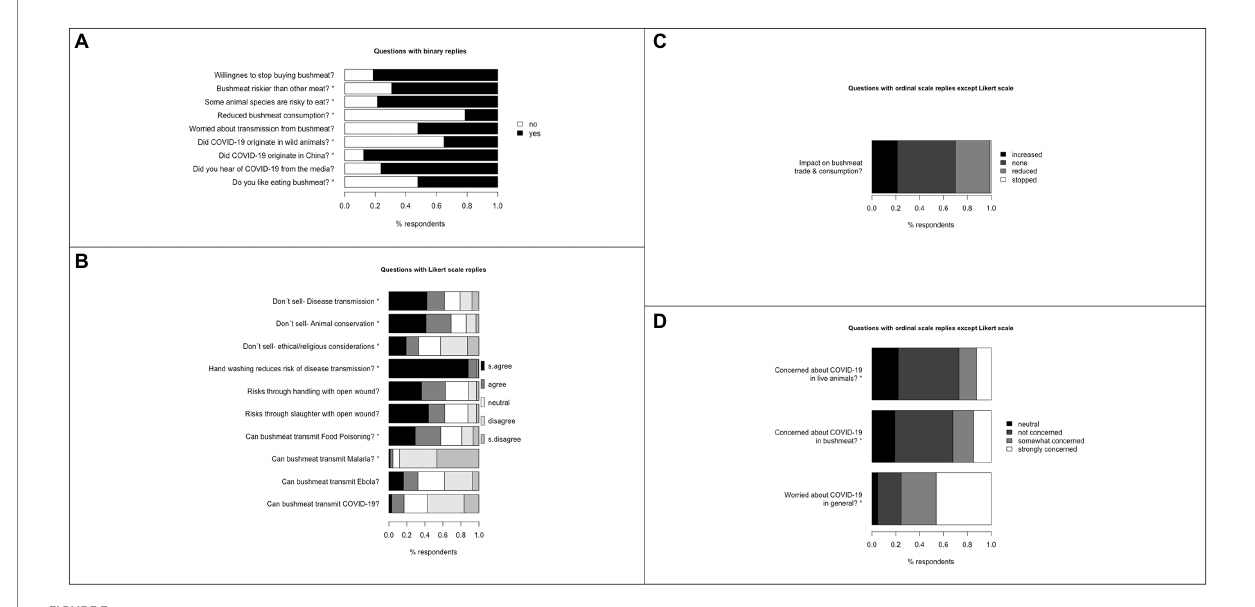
FIGURE 3 Reply characteristics to questions whose replies were in binary scale (A) , ordinary scale except Likert (B) and ordinary Likert scale (C,D) . Questions marked with * indicate those where replies significantly deviate for at least one independent variable after Benjamini and Hochberg (1995) correction for false discovery